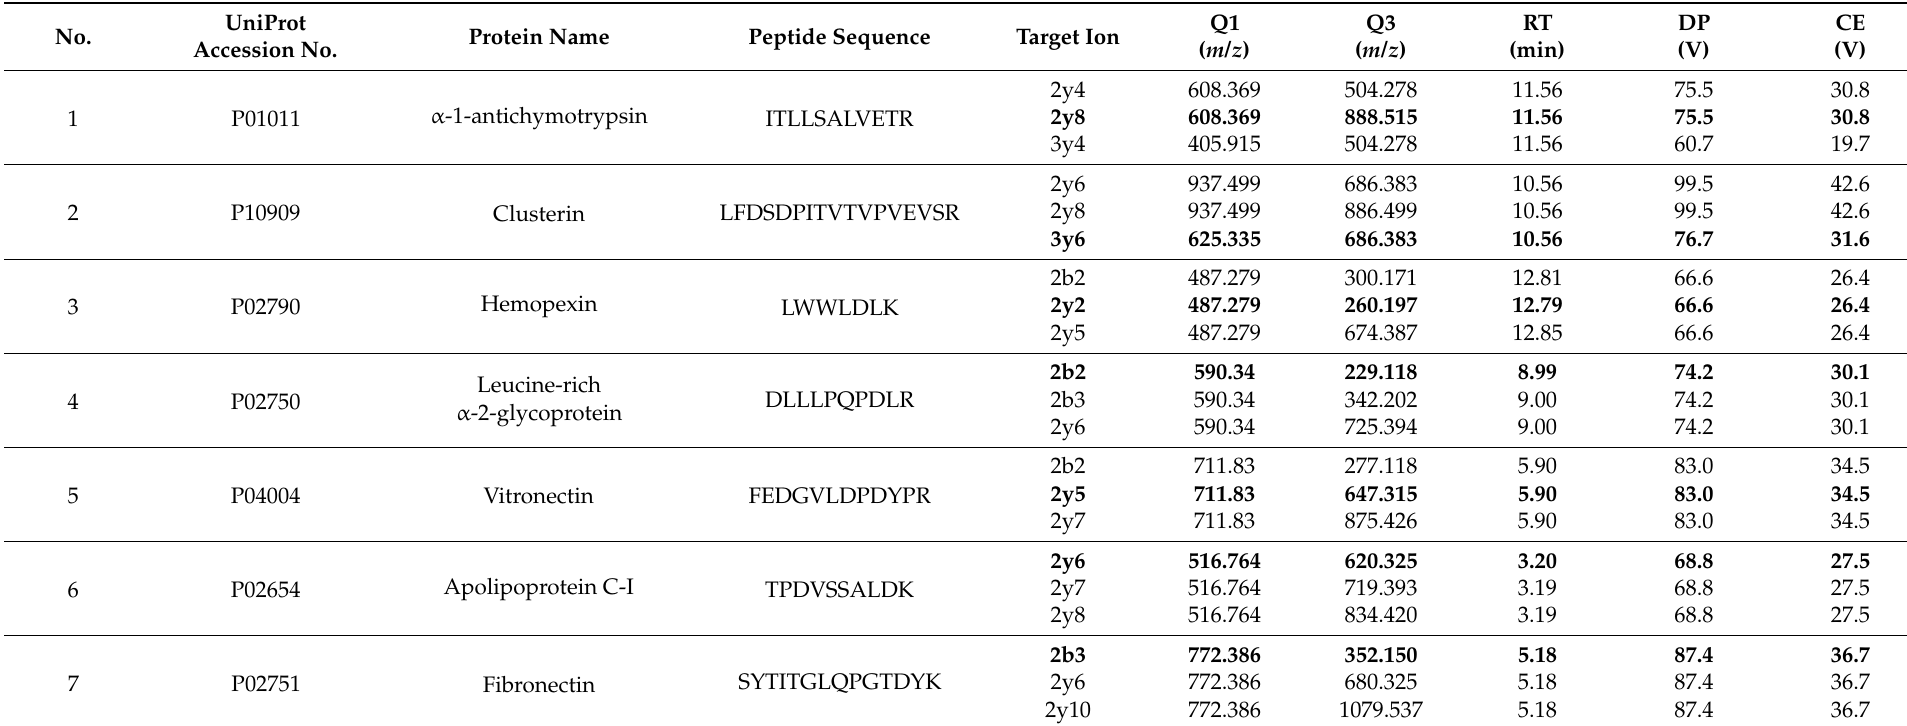
Table 2. Parameters of the multiple reaction monitoring (MRM) acquisition mode for ACS diagnostic biomarker